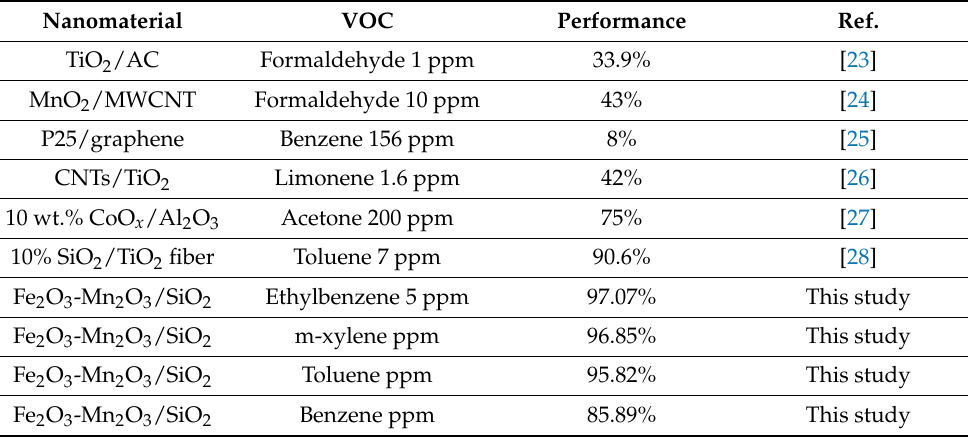
Table 2. Comparison of VOCs removal performance by the nanomaterials used in this study with other